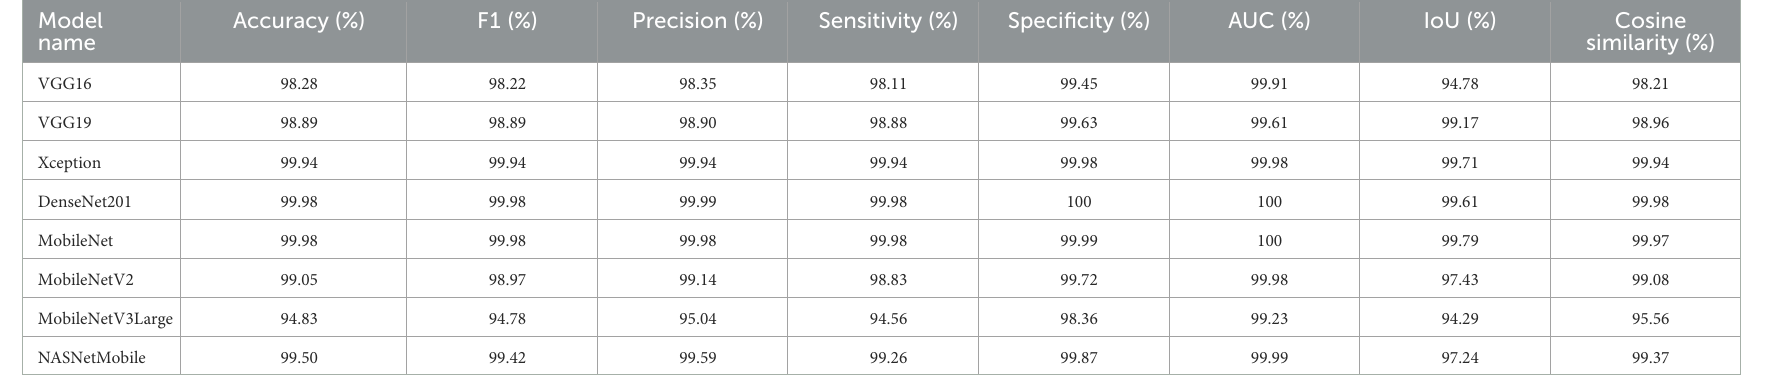
TABLE 10 The Four-classes dataset evaluates the maximized